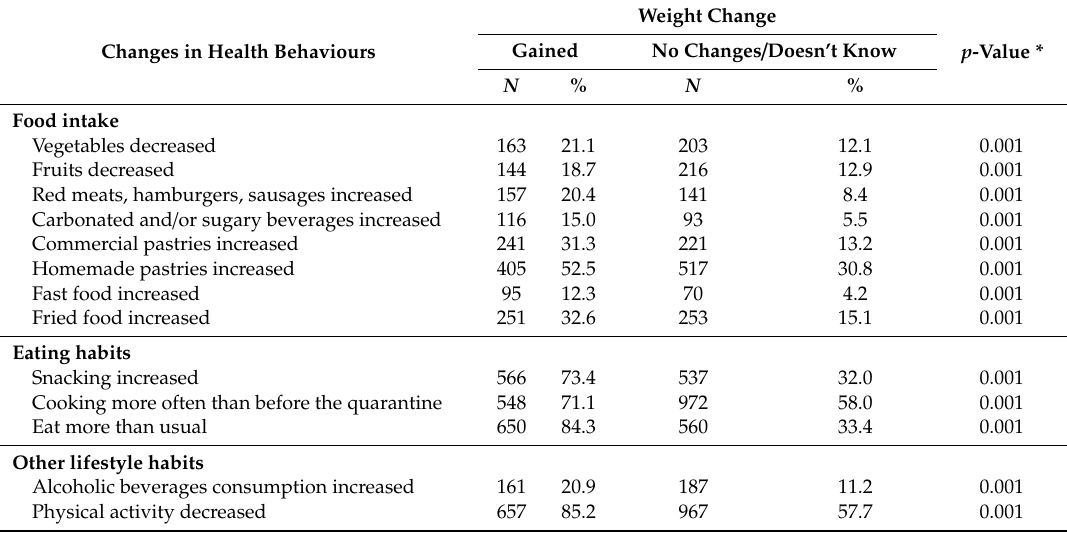
Table 3. The proportion of participants who reported changes in health behaviours by changes in weight